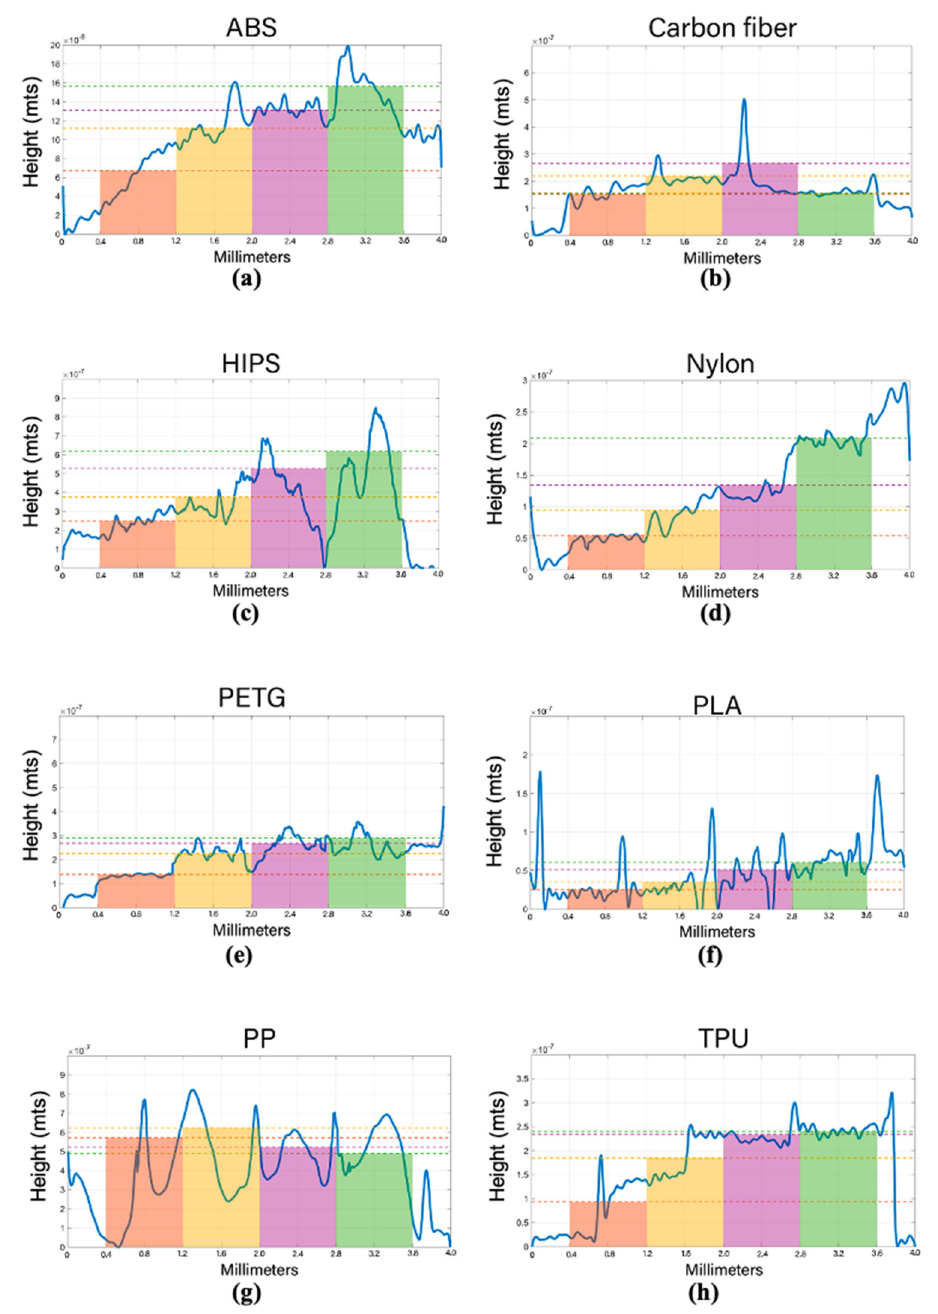
Figure 9. The average thickness of the microparticle film deposited on the collecting area: ( a ) ABS, ( b ) carbon fiber, ( c ) HIPS, ( d ) Nylon, ( e ) PETG, ( f ) PLA, ( g ) PP, ( h ) TPU.